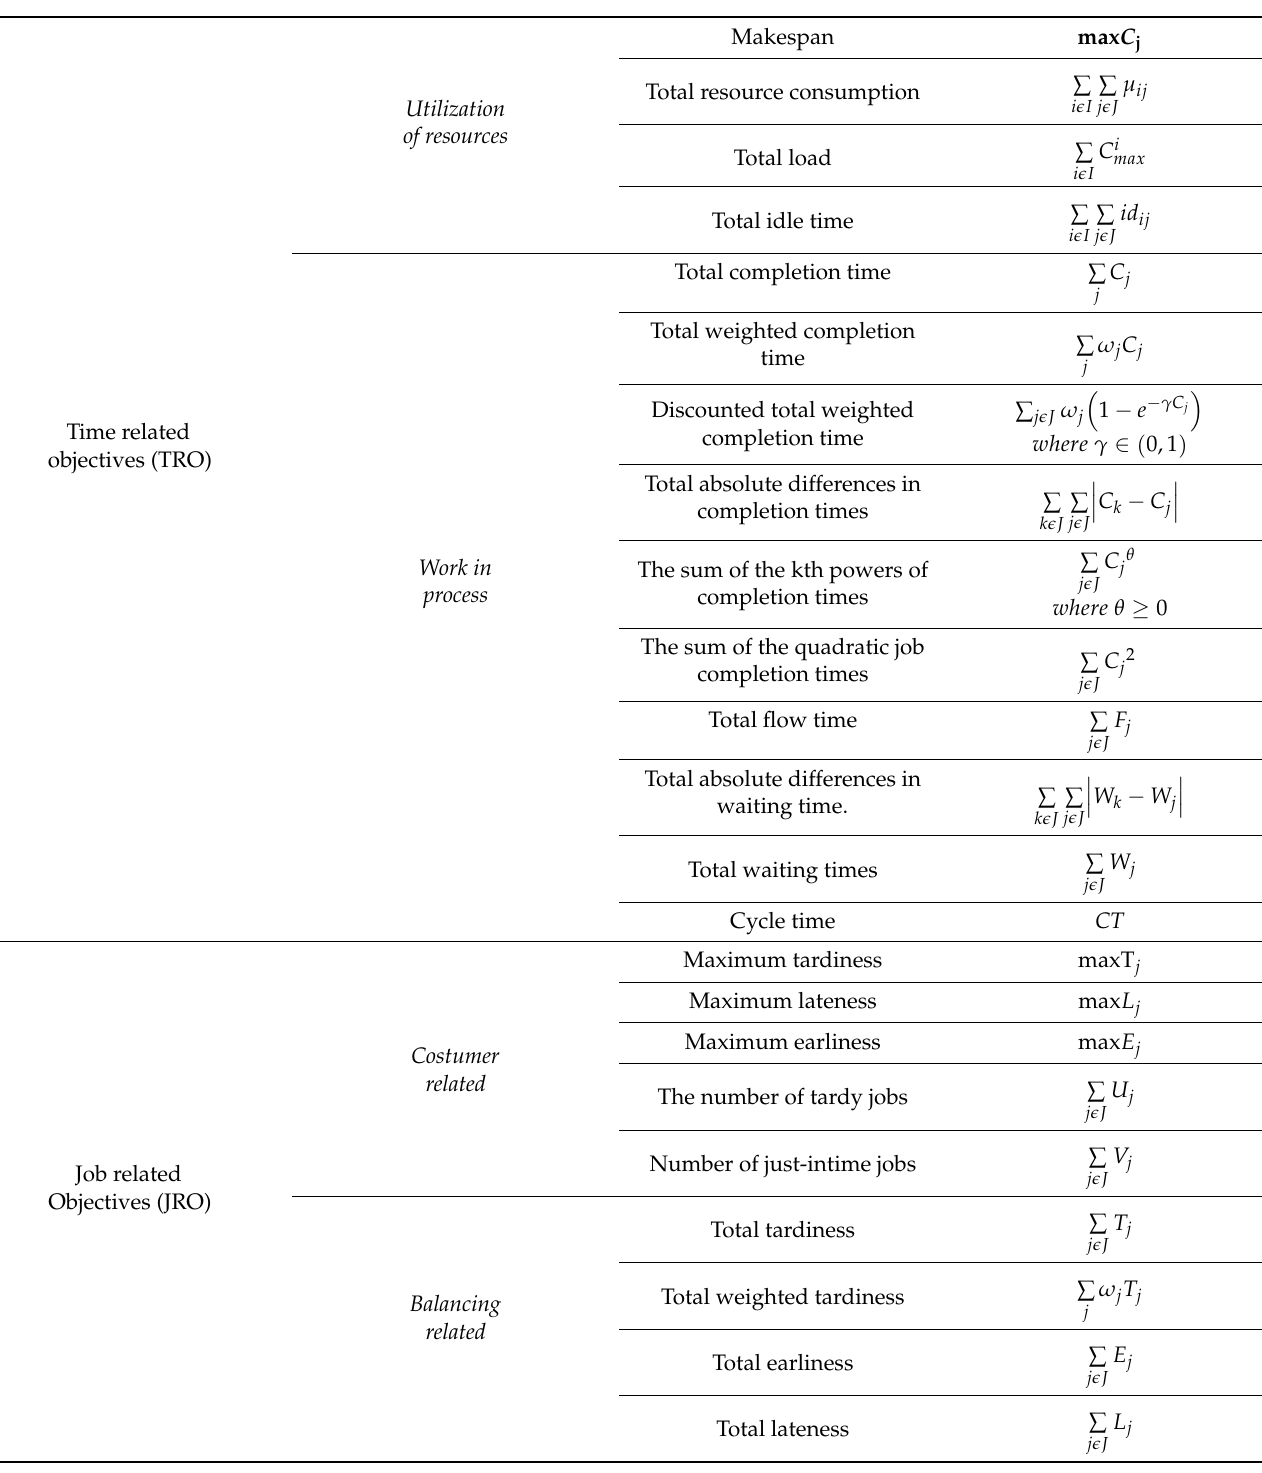
Table A1. Categories for objective functions